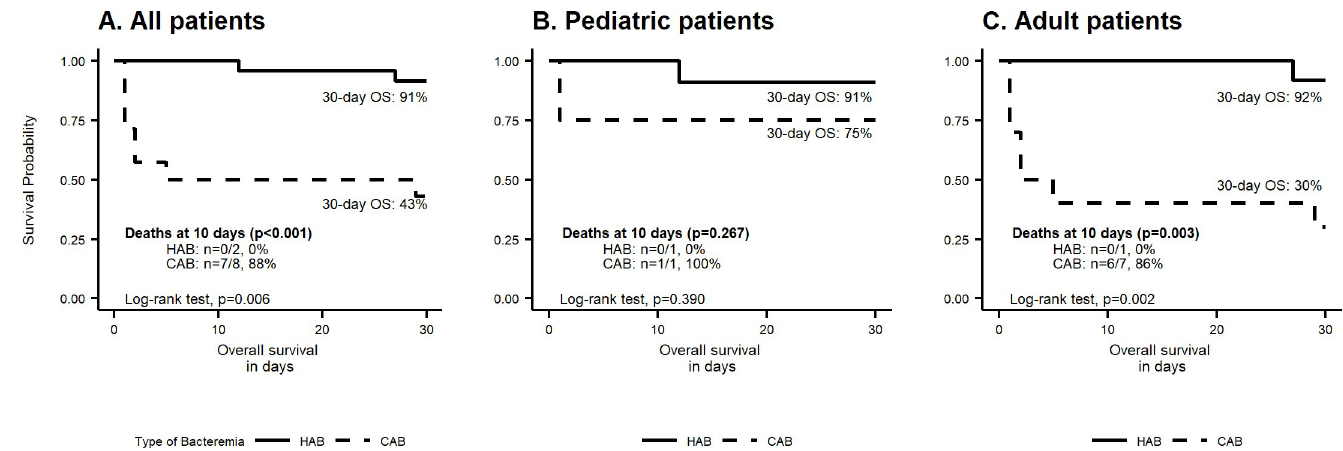
Fig 1. Kaplan-Meier analysis of the overall survival between the type of bacteremia in the total population (A) pediatric (B), and adult patients (C). OS, Overall survival; HAB, Healthcare-associated bacteremia; CAB, Community-acquired bacteremia.